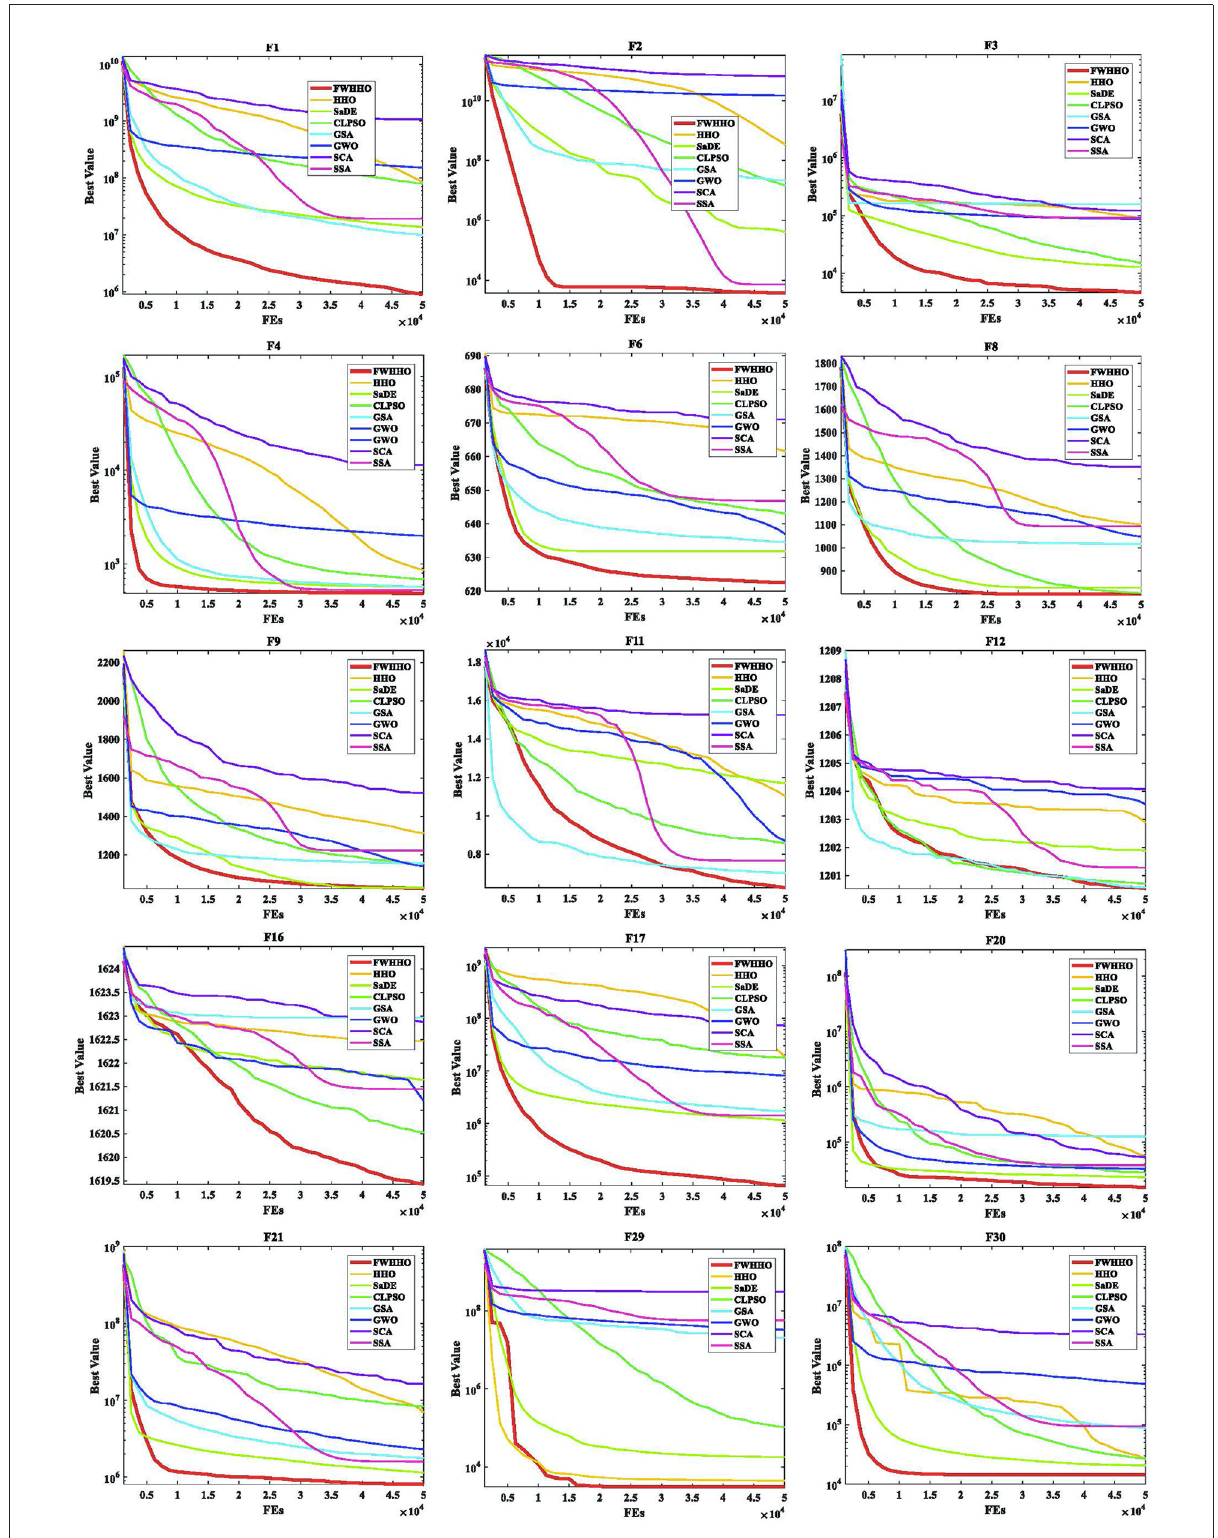
FIGURE1 Convergence curves of FWHHO and state-of-the-art